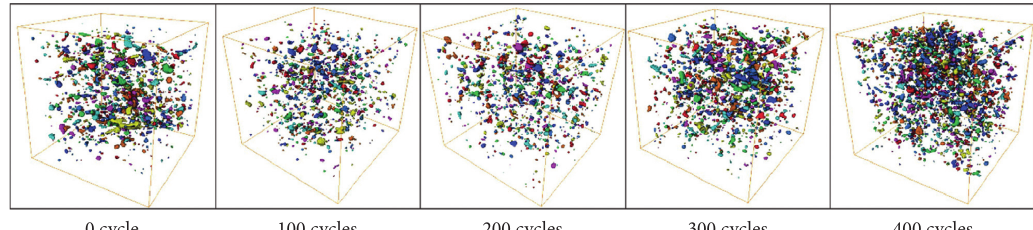
Figure 17: Cube-pore image of 10% CaO expansive concrete (C-10) under different freeze-thaw